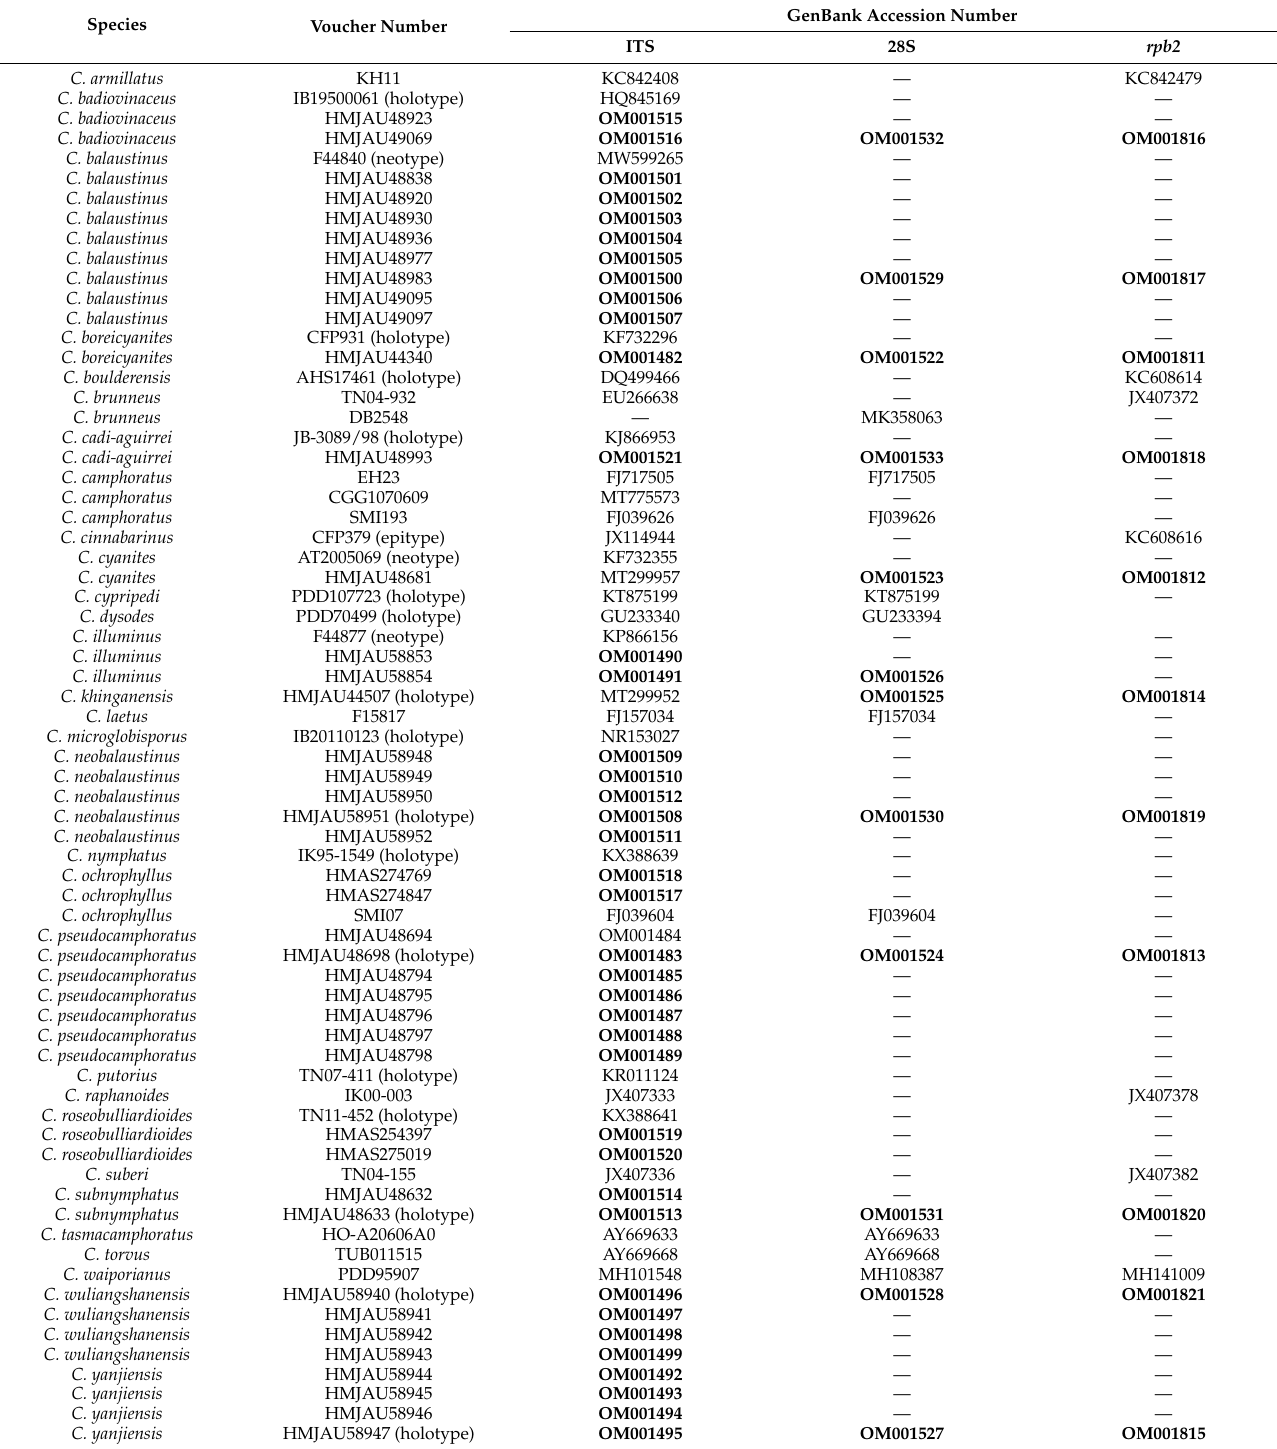
Table 1. Sequences used in the phylogenetic analyses.